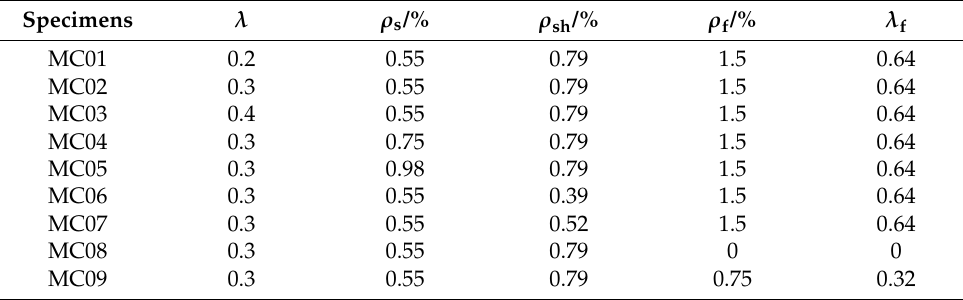
Figure 1. Specimens’ dimension and reinforcement arrangement: ( a ) MC01 specimen; ( b ) MC02 specimen; ( c ) MC03 specimen; ( d ) MC04 specimen; ( e ) MC05 specimen; ( f ) MC06 specimen; ( g ) MC07 specimen; ( h ) MC08 specimen; ( i ) MC09 specimen. Table 1. Design parameters of the